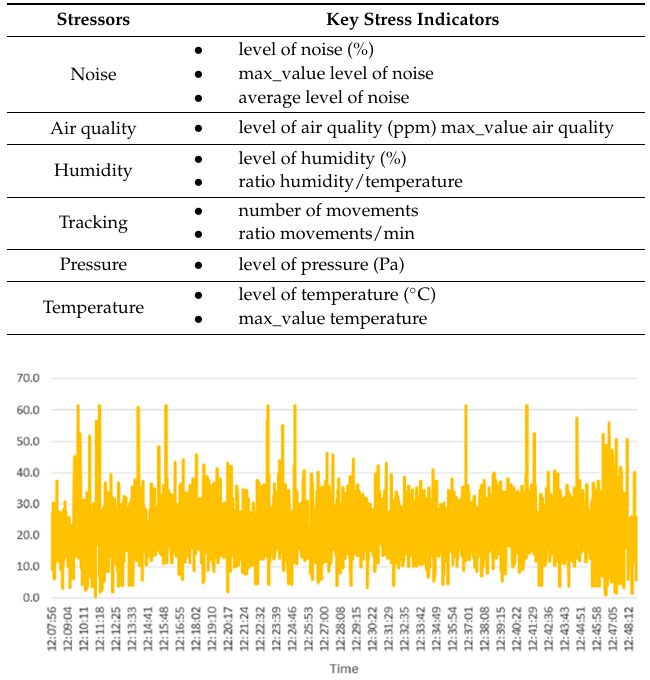
Figure 9. Evolution of the level of sound monitored by the sensing module in the restaurant.